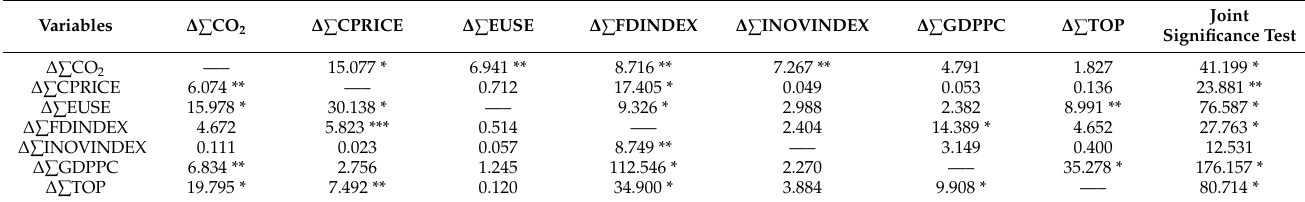
Table 8. VAR Granger Causality Estimates.